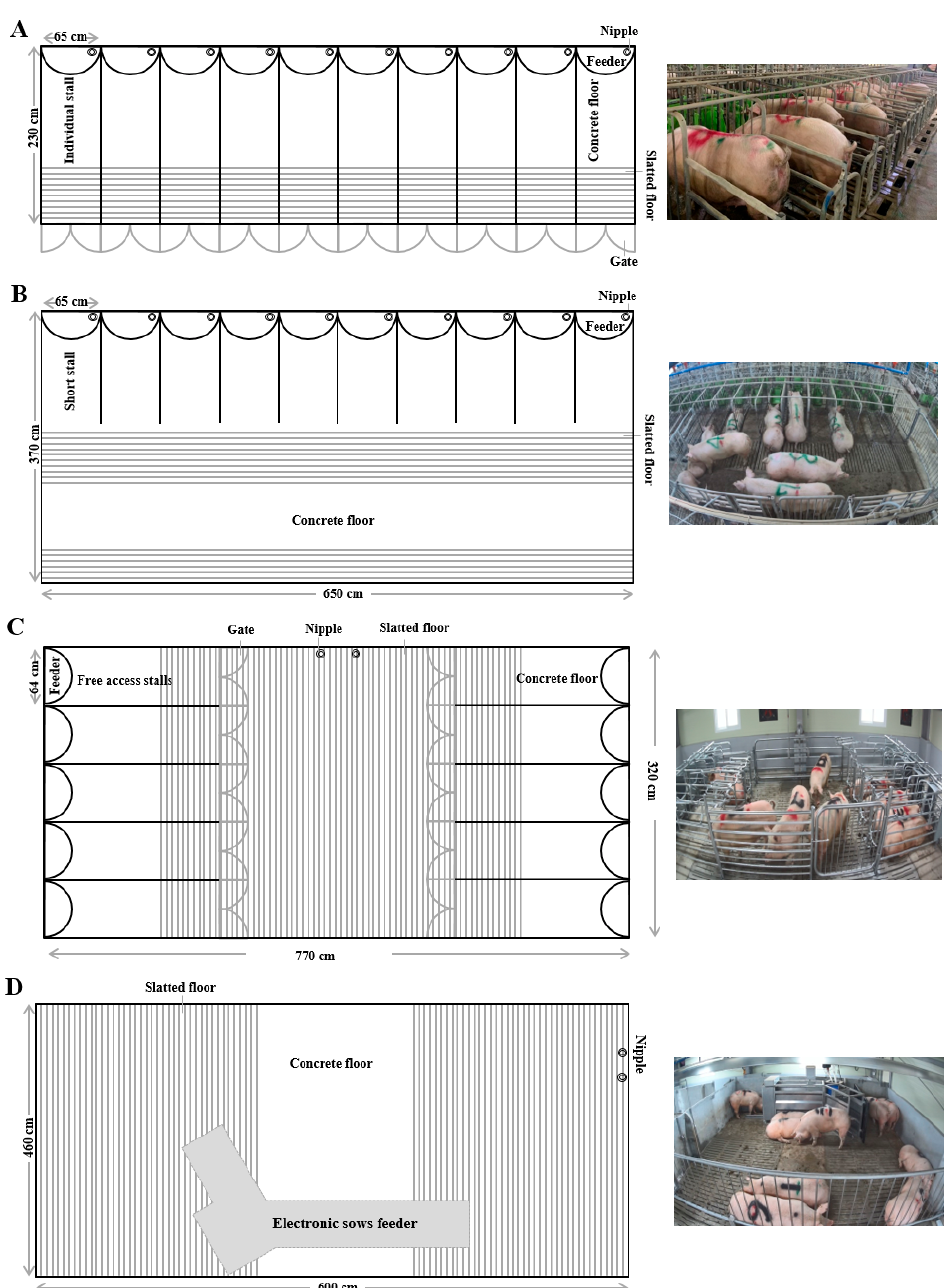
Figure 1. Types of group housing facilities of sows. ( A ) Individual stalls (IS). ( B ) Short stalls (SS). ( C ) Free access stalls (FAS). ( D ) Electronic sow feeders (ESF).